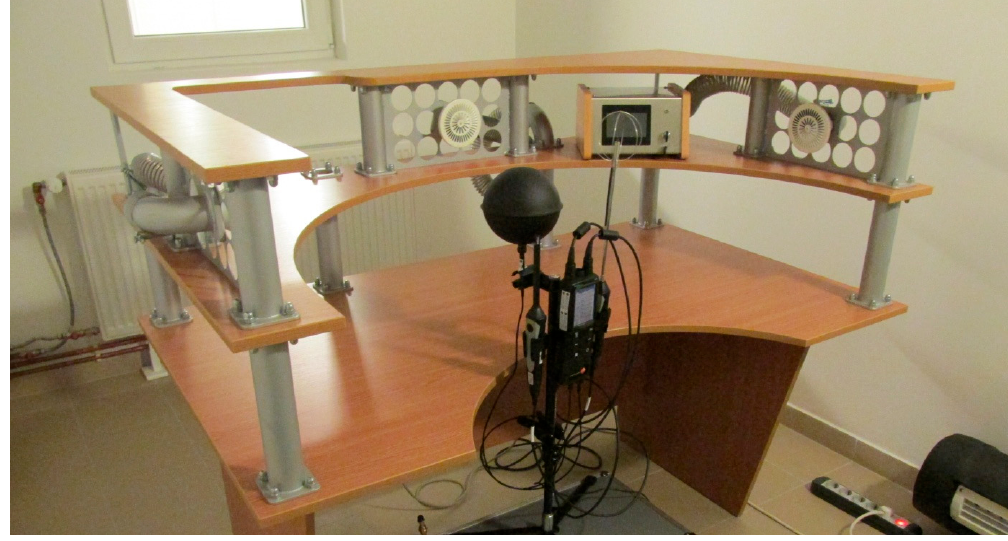
Figure 1. ALTAIR PV equipment.